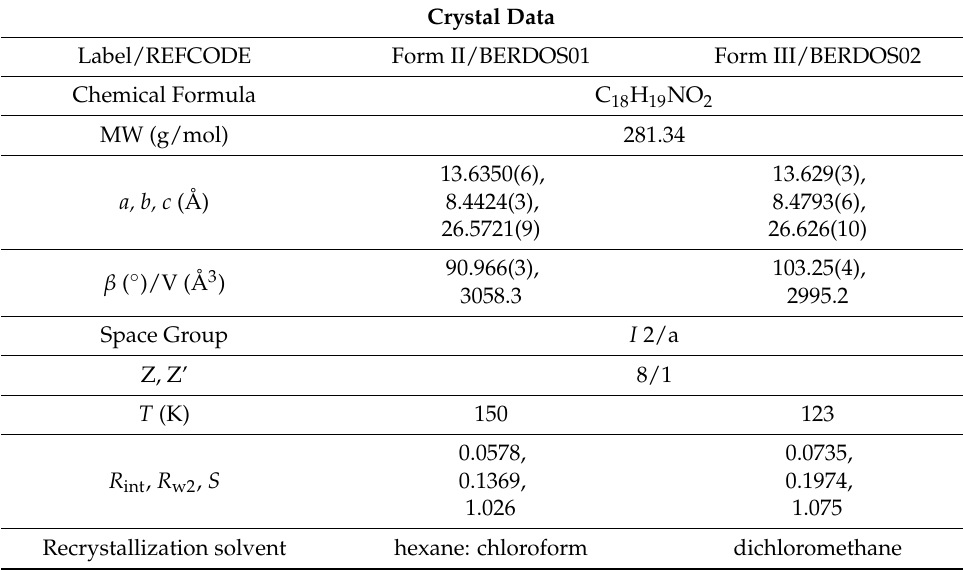
Table 1. Crystallographic information for both forms of 2-benzoyl- N,N -diethylbenzamide. Crystal